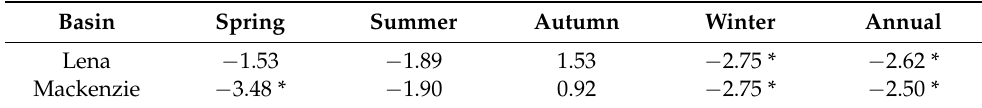
Figure 4. TWS variations in the MRB and LRB estimated by GRACE data during 2003–2016. ( a ) annual TWS; ( b ) seasonal TWS. Table 3. The results of the TFPW-MK test for TWS in Lena and Mackenzie. Values exceeding 1.96 represent upward significant trends, whereas those less than 1.96 represent decreasing trends at α <